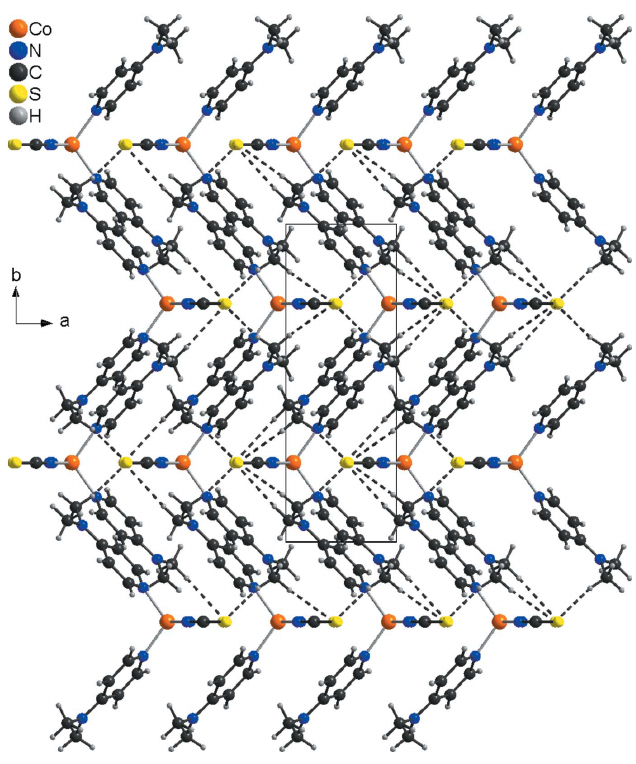
Figure 4 Crystal structure of form I viewed in the direction of the crystallographic c -axis. Intermolecular C—H (cid:2)(cid:2)(cid:2) S hydrogen bonding is shown as dashed